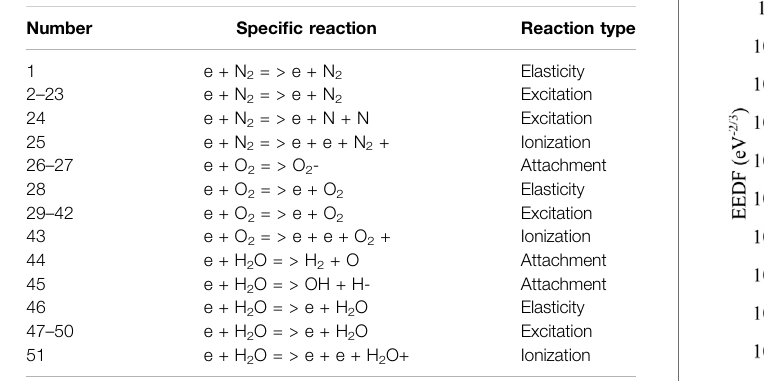
TABLE 1 | Applied electron collision reactions.